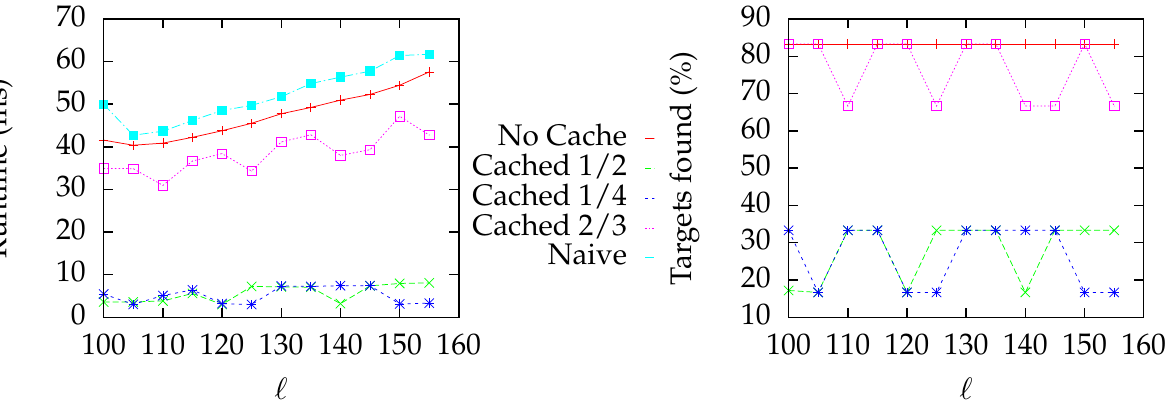
Figure 7. Evaluation on a star-shaped graph similar to Figure 6. Here, the distance between s and a target vertex u i is i 2 + /2. We evaluated Dijkstra’s algorithm ( Naive ), our implementation using |T | Dijkstra’s algorithm without caching ( No Cache ), and when caching a query vertex whose distance to s is 1/4, 1/2, and 2/3 of the distance from s to s ’s closest target. We call these instances Cached 1/4 , Cached 1/2 , and Cached 2/3 , respectively, in the legend.